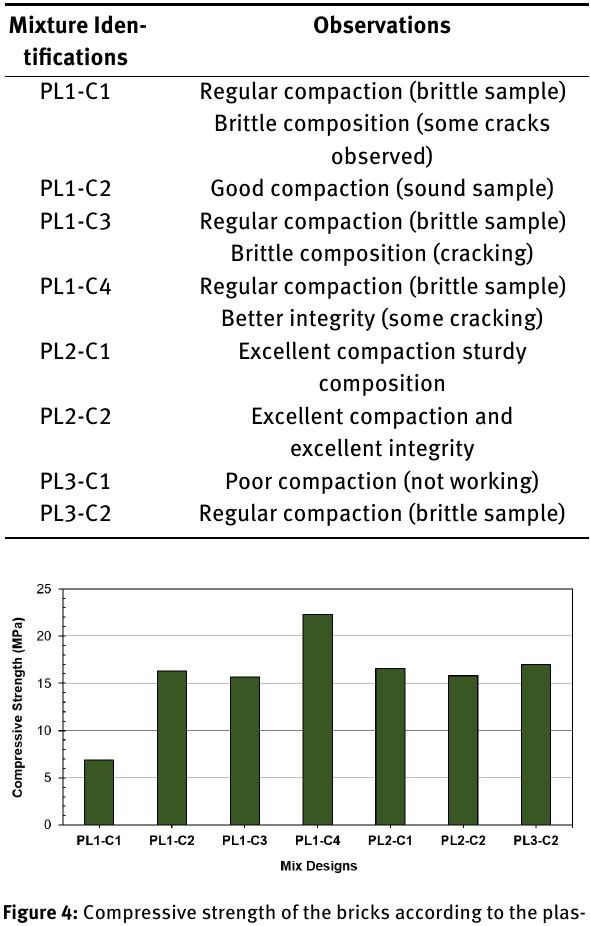
sive strength of each brick type, ranging from 6.9 to 22.3 MPa. Mixture PL3-C1 could not retain its shape after cast- ing; therefore, it did not undergo curing and subsequent structural tests.